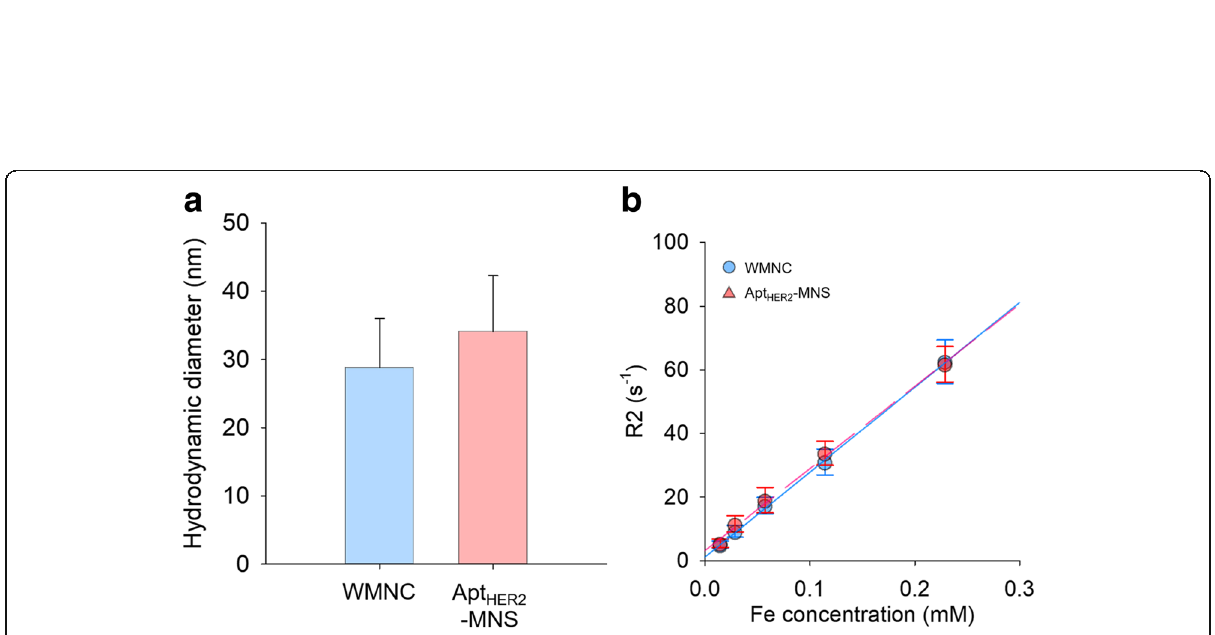
Fig. 3 The characterization of WMNCs and Apt HER2 -MNS for using as in vivo MRI contrast agent. a hydrodynamic diameter ( n =5, WMNCs 28.8±7.2 nm, Apt HER2 -MNS 34.1±8.2 nm). b Relaxivity analysis graph ( n =3, WMNCs R 2 =265.7 mM − 1 s − 1 , R 2 =0.99 and Apt HER2 -MNS R 2 =257.2 mM − 1 s − 1 , R 2